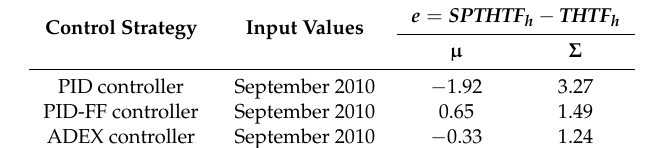
Table 3. Comparison of results (September 2010).